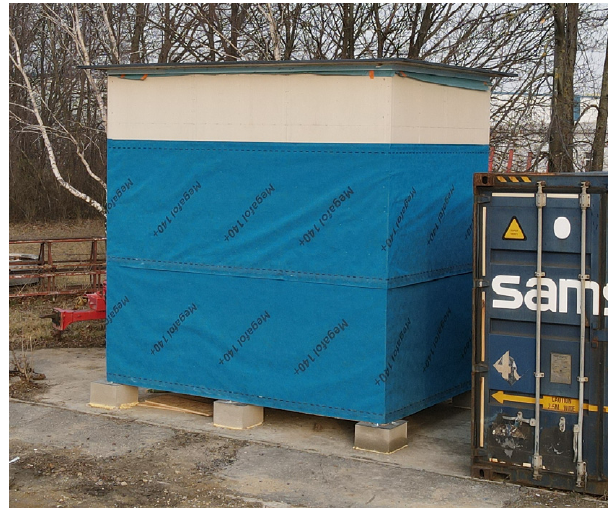
Figure 28. View of a test cell under construction. (Photo archive: Ingeli).